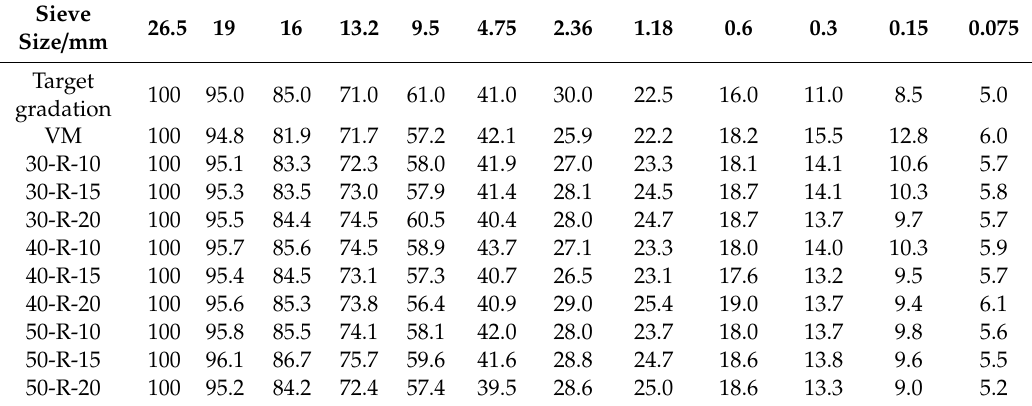
Table 8. Composite gradations of mixtures with various percentages of reclaimed asphalt pavement (RAP) and fine reclaimed asphalt pavement (FRAP).